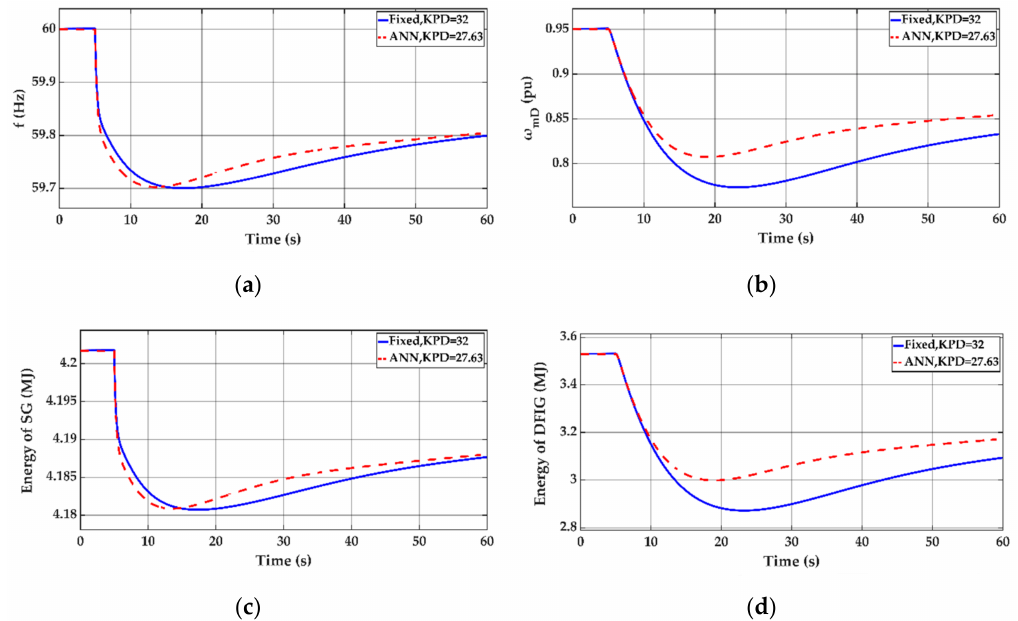
Figure 12. Dynamic response curves from the ANN-based controller and fixed-gain controller ( ∆ P Load = 40 MW, wind penetration = 29.4%, and V = 11 m / s). ( a ) Frequency, ( b ) DFIG speed, ( c ) SG energy, W and ( d ) DFIG